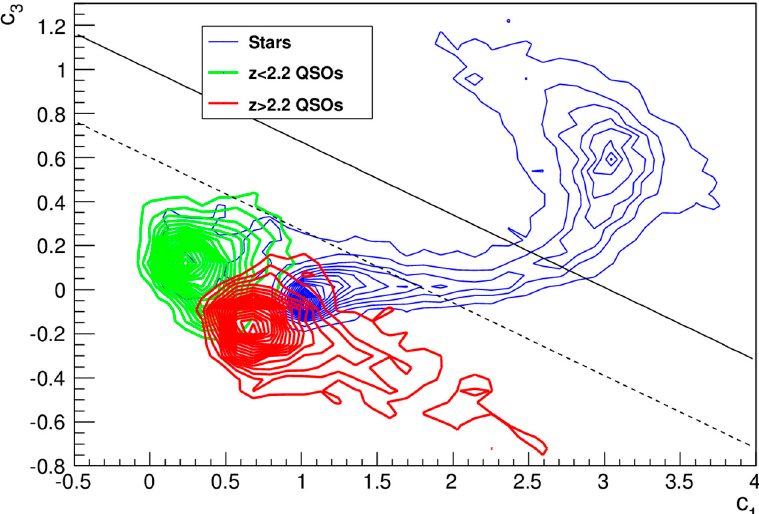
Figure 3. The BOSS + MMT color selection criteria [6]. Locus of stars (upper blue contours), z < 2.2 quasars (lower left green contours), and z > 2.2 quasars (lower right red contours) in the c3 vs. c1 color-color plane. The upper solid line corresponds to the color cut c3 < 1.0 − c1/3 (loose, for point sources) and the lower dashed line to c3 < 0.6 − c1/3 (strict, for extended sources). c1 = 0.95(u − g) + 0.31(g − r) + 0.11(r − i), c3 = − 0.39(u − g) + 0.79(g − r) + 0.47(r − i), where u, g, r, i and z are SDSS colors.